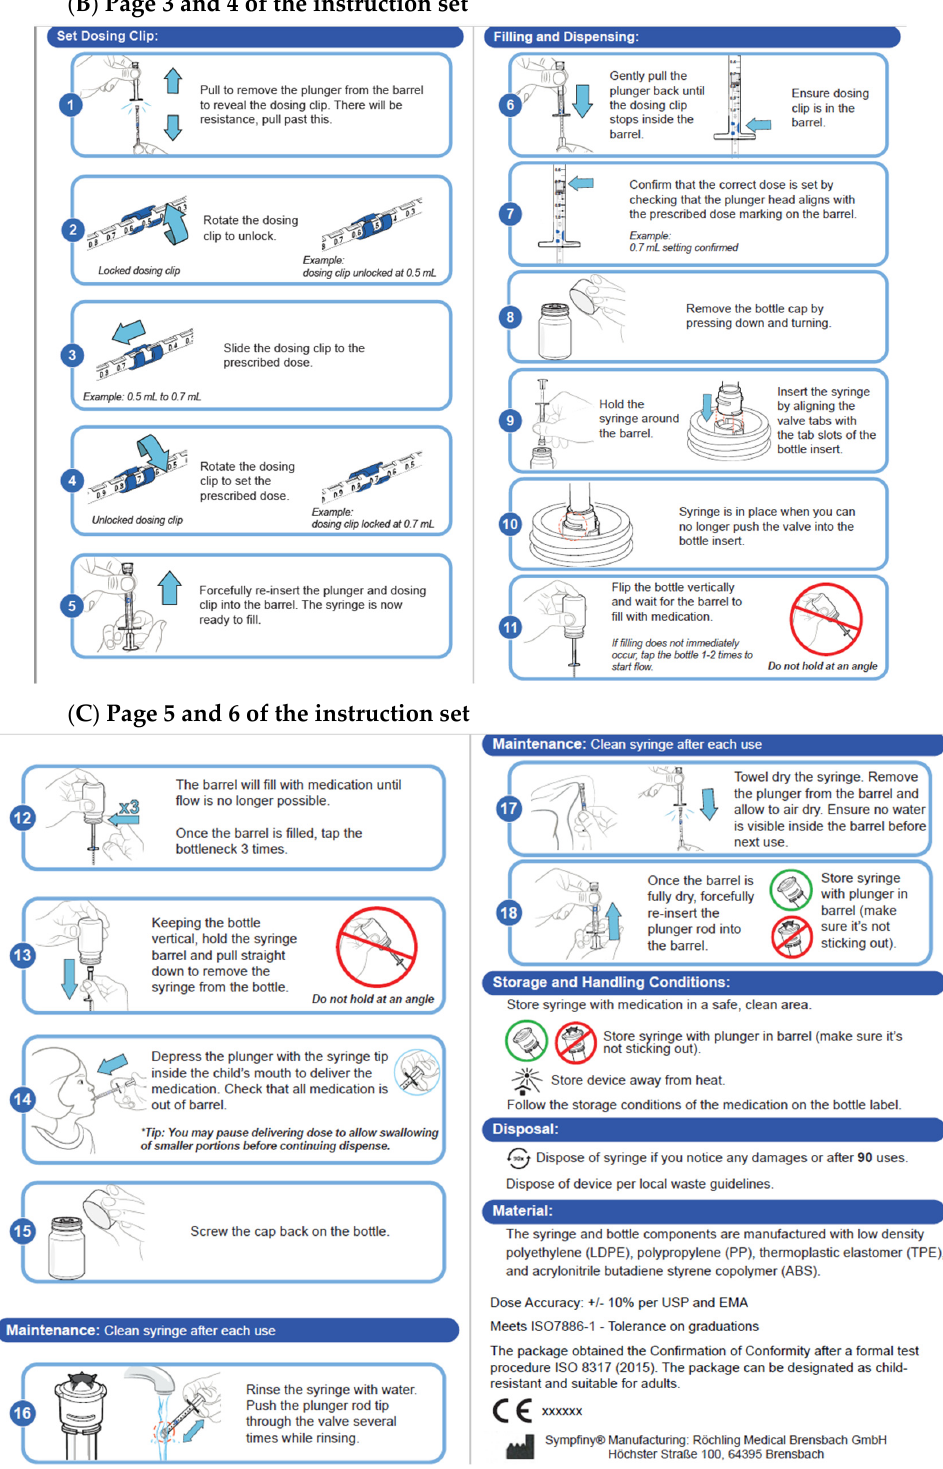
Figure A1. Instruction set provided to the participants. ( A ) Pages 1 and 2. ( B ) Pages 3 and 4. ( C ) Pages 5 and 6.